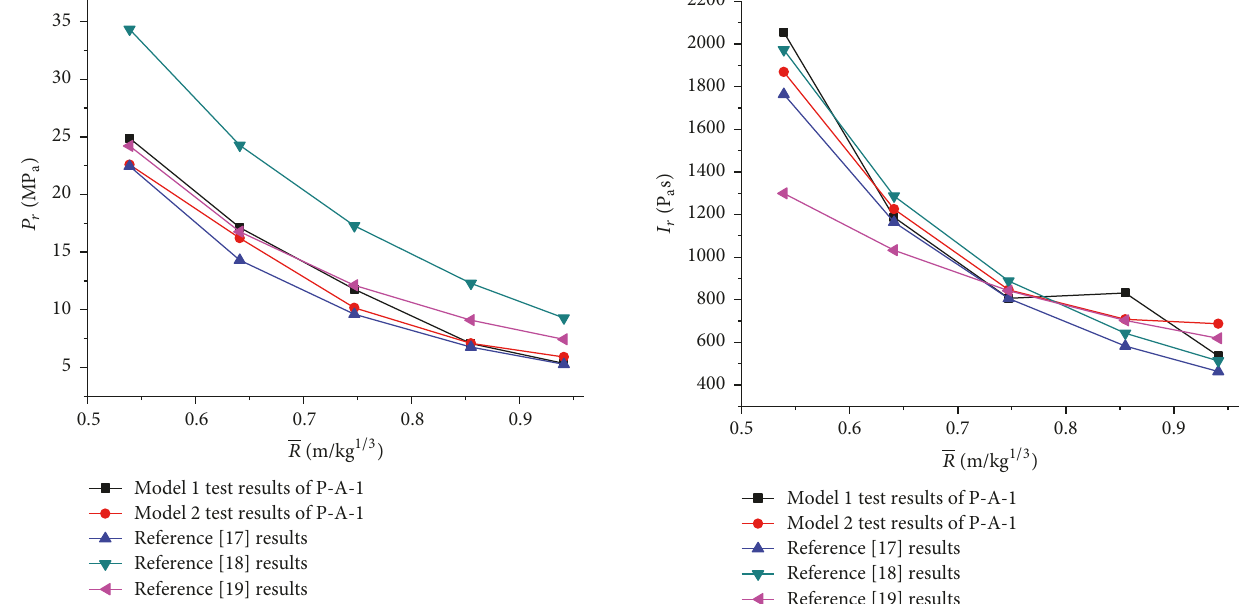
Figure 9: Comparison between the test data of reflected shock overpressure peak and computed results.